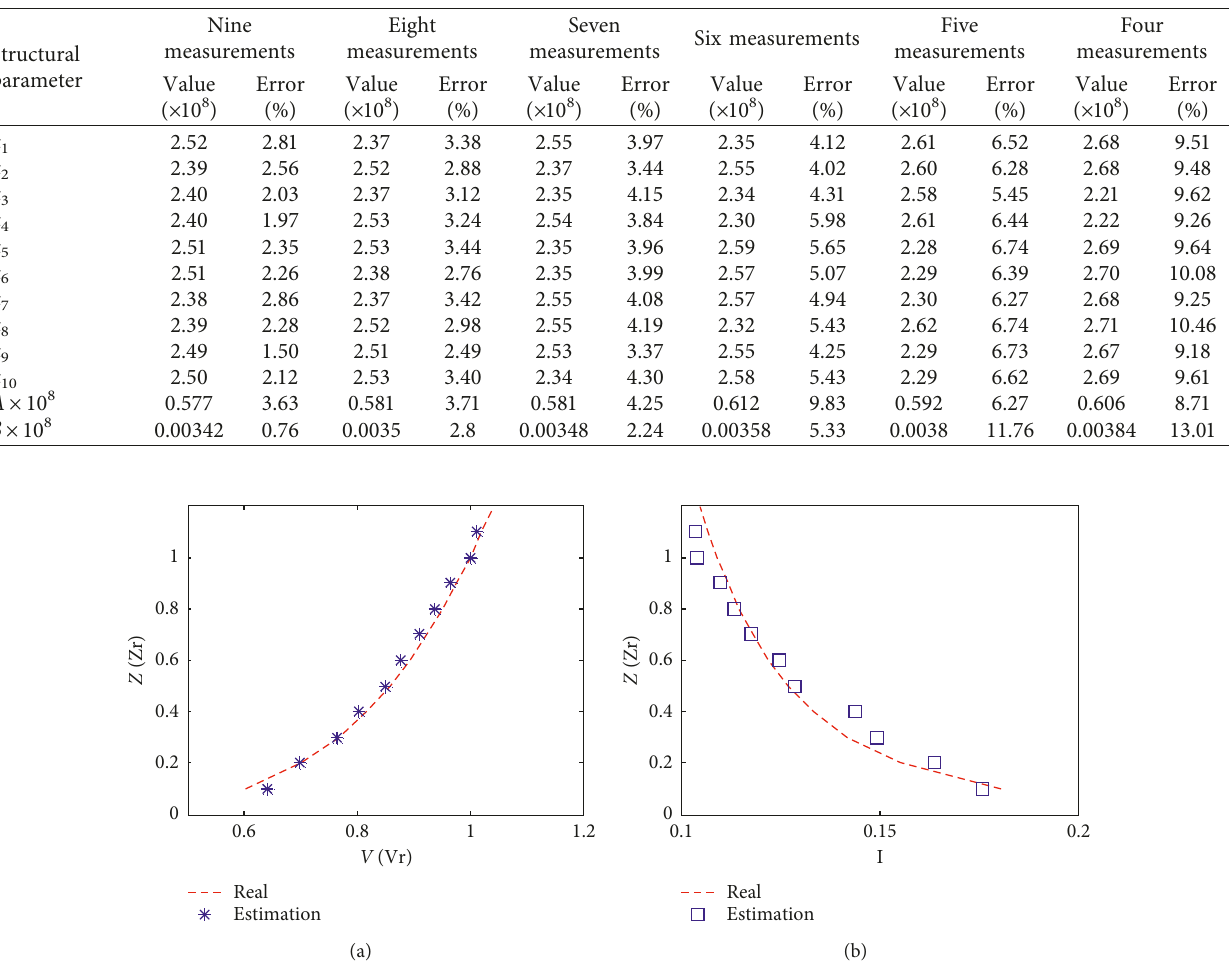
Figure 10: Estimated damping coefficients for different numbers of measurements: damping coefficients (a) α and (b) β . Table 8: Estimation of structural parameters under different numbers of measurements.